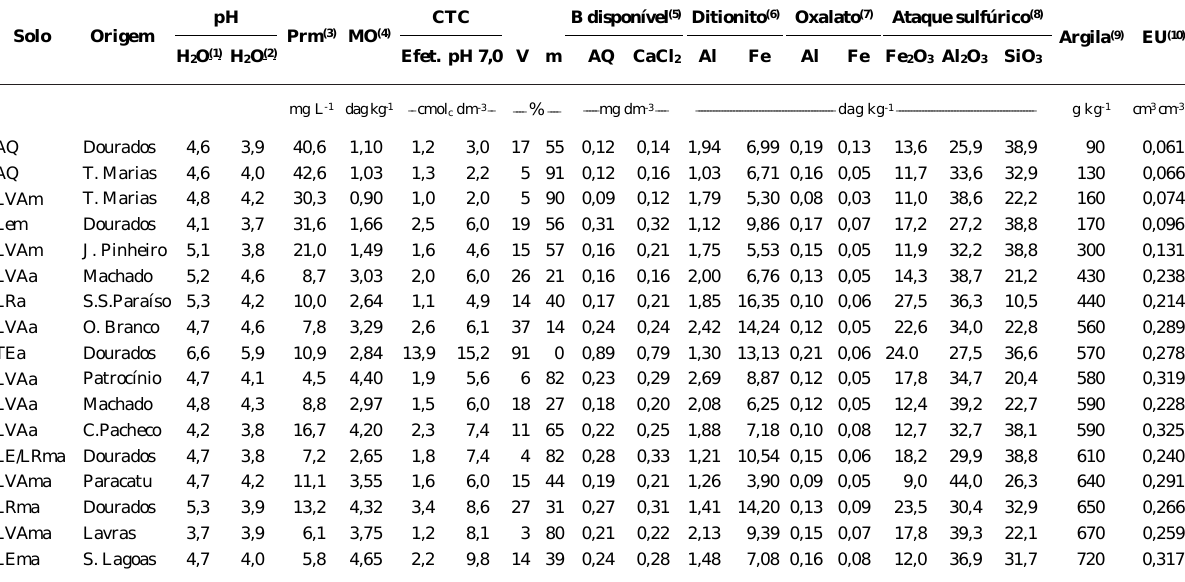
AQ LVAm Lem LVAm LVAa LRa LVAa TEa LVAa LVAa LVAa LE/LRma LVAma LRma LVAma